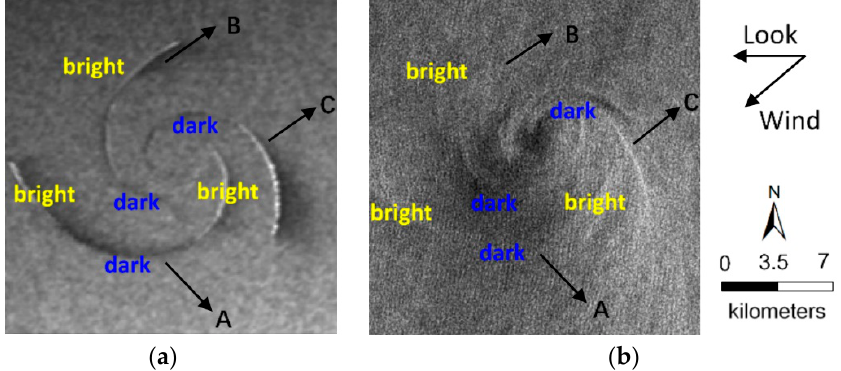
Figure 7. Comparison of ( a ) the simulated SAR eddy image and ( b ) the ENVISAT-1 ASAR image under the same radar parameters and wind field conditions. The radar look and wind direction are indicated by black arrows.